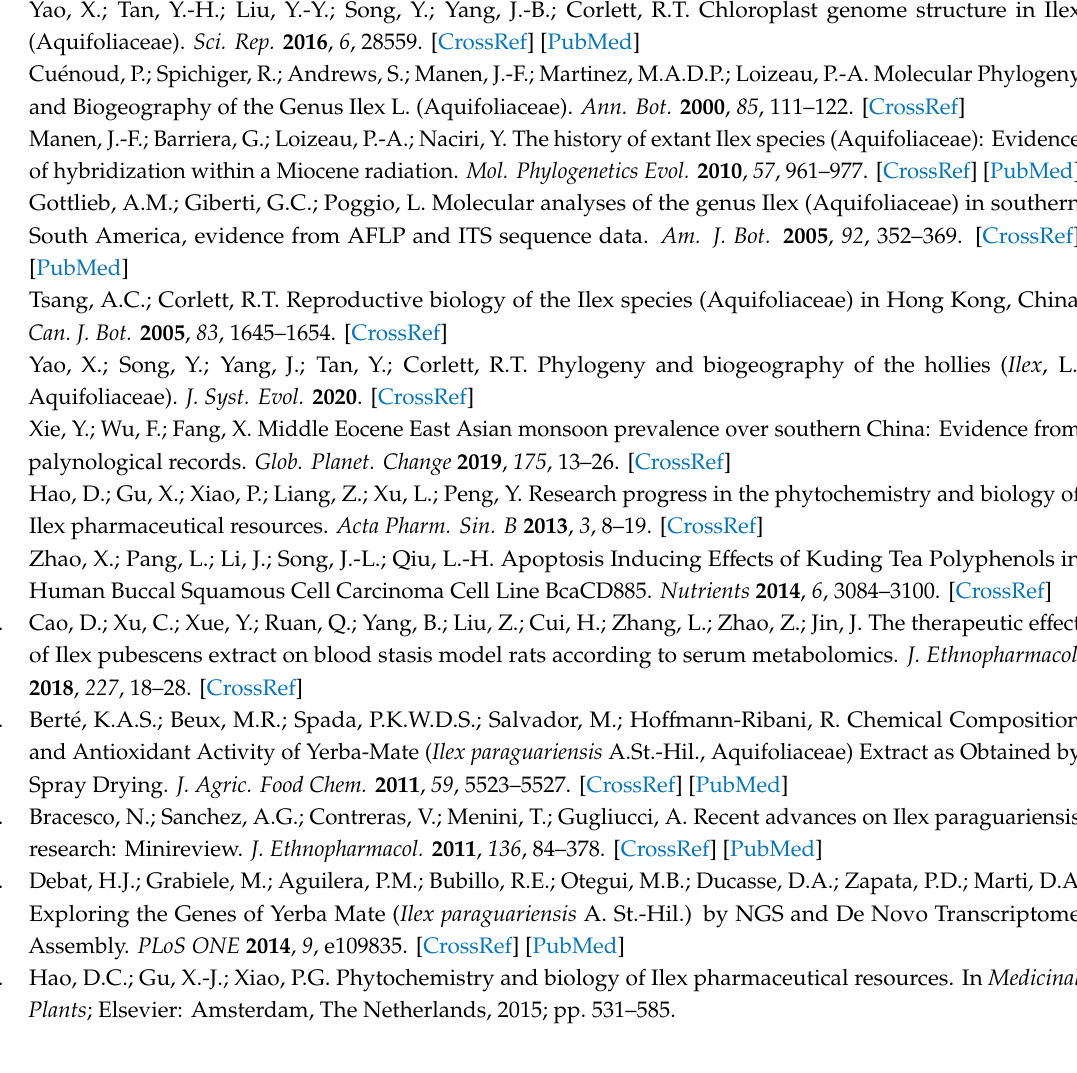
Figure S1: Analysis of SSRs in four Ilex plastid genomes, Figure S2: Analysis of the long repeated sequences in four Ilex plastid genomes, Figure S3: The phylogenetic analysis of 15 Ilex species using the coding sequences, Table S1: Base composition and proportions of the four Ilex plastid genomes, Table S2: Statistical analysis of codon usage, RSCU values, codon-anticodon recognition patterns of four Ilex plastid